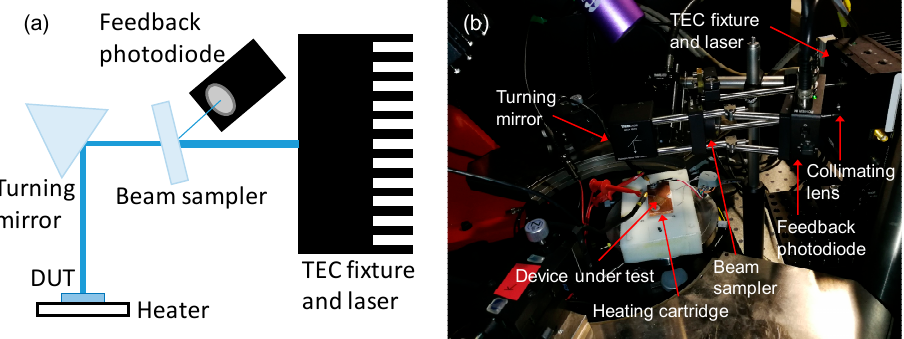
Figure 3. ( a ) Block diagram and ( b ) photo of the laser-based wireless power transfer system. All the main parts are highlighted.